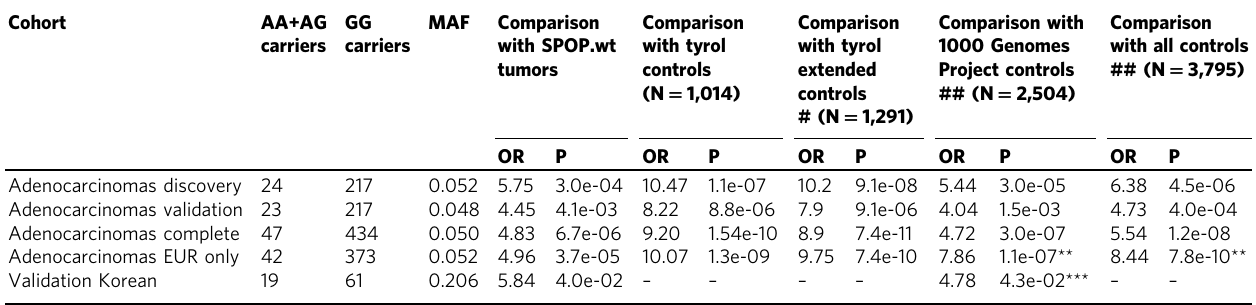
Table 1 Association signal of variant 7p14.3 with SPOP somatic phenotype